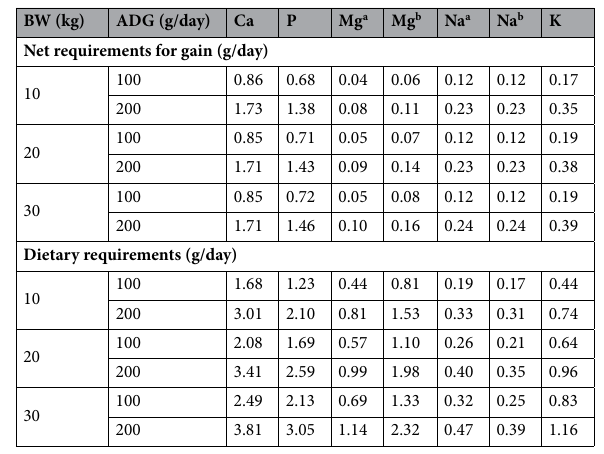
Table 5. Net mineral requirements for gain and total dietary requirements of intact and castrated male Santa Ines hair sheep. BW body weight, EBW empty BW, ADG average daily gain. a Intact male; b castrated